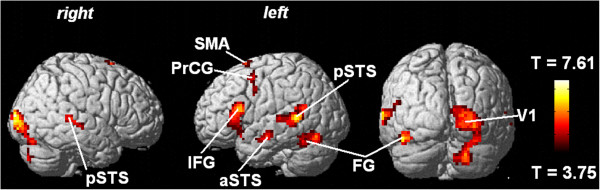
Whole-head covariance analysis (ultra-fast speech perception as a covariate). SPM random-effects group analysis (14 blind, 12 sighted subjects): Effects of ultra-fast speech comprehension capabilities (= covariate) within the SPM T-contrast “ultra-fast speech versus baseline”. Left- and right-hemispheric hemodynamic responses exceeding a threshold of p < 0.0005 (uncorrected) at a voxel level and p < 0.05 (corrected) at a cluster level are color-coded in terms of T values (height threshold). The respective SPM coordinates are listed in Table 2. Abbreviations: aSTS, anterior superior temporal sulcus; FG, fusiform gyrus; IFG, inferior frontal gyrus; PrCG, precentral gyrus; pSTS, posterior superior temporal sulcus; SMA, supplementary motor area; V1, primary visual area.